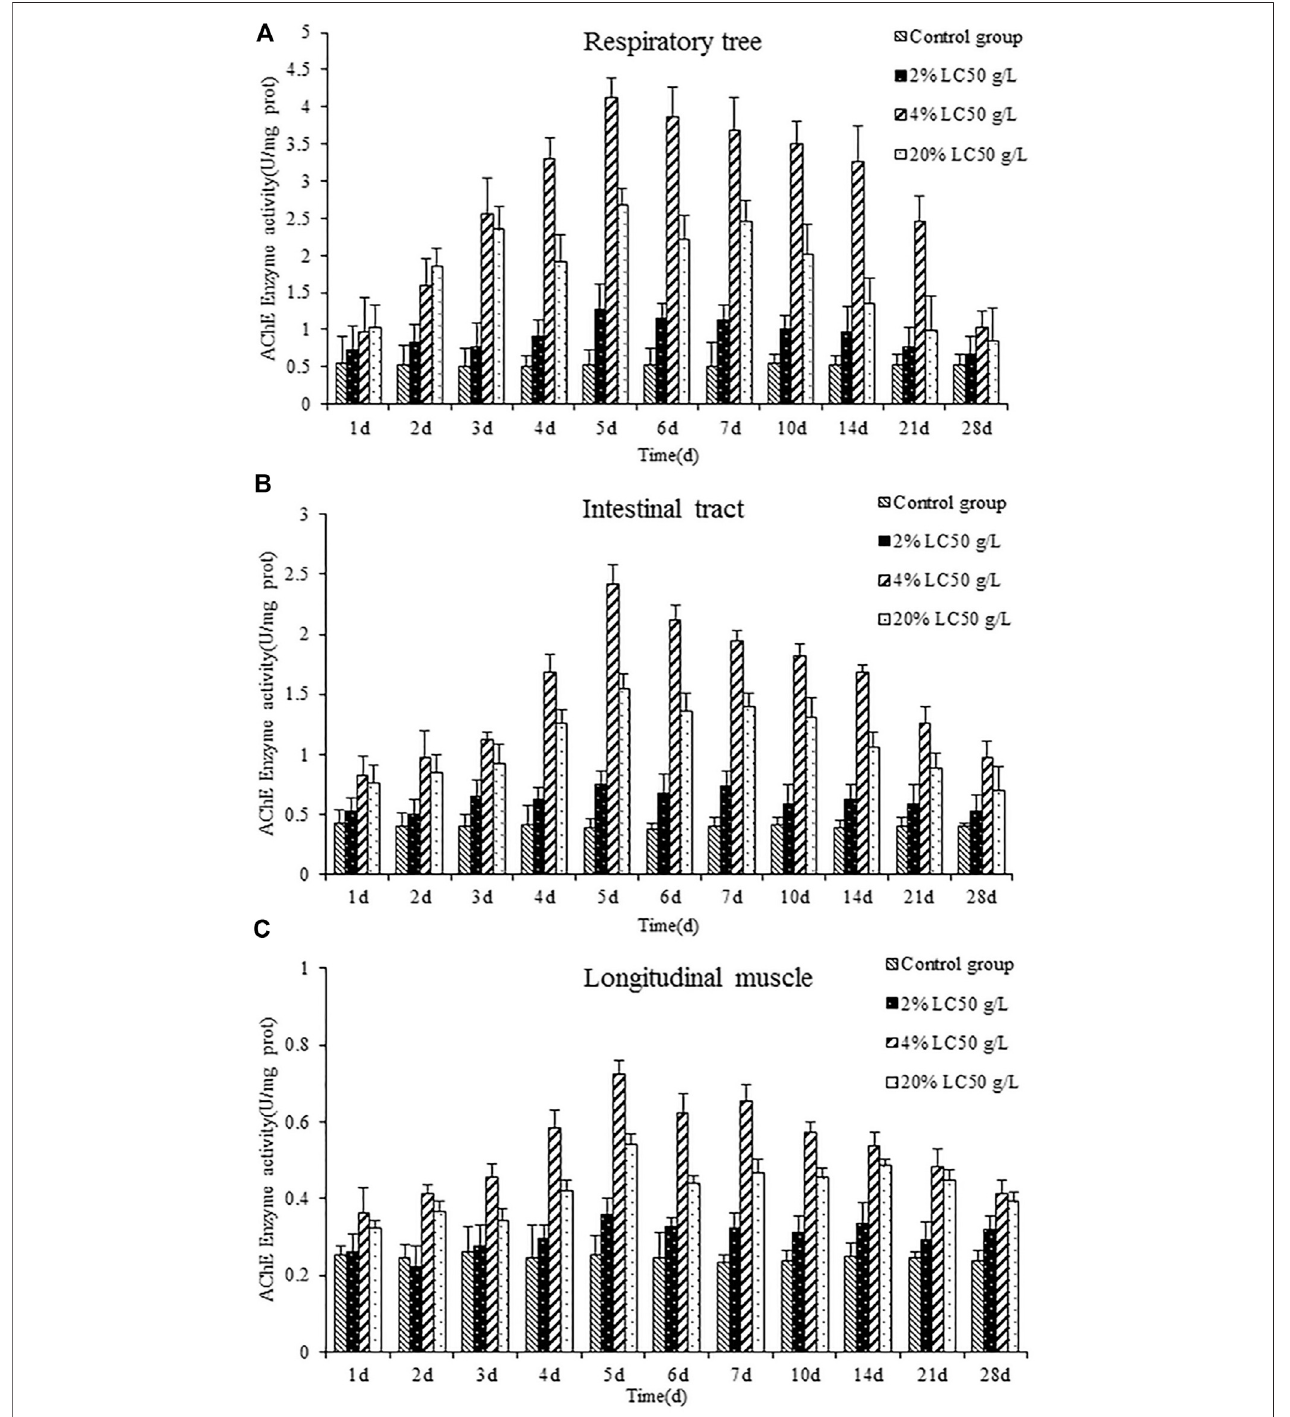
FIGURE 4 | AChE activity of the respiratory tree (A) , intestinal tract (B) , and longitudinal muscle (C) in A. japonicas .